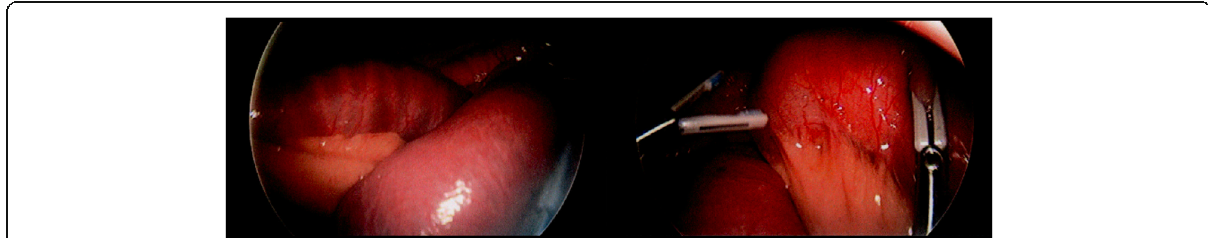
Fig. 2 Dilated loops of bowel. Intraoperatively, hyperemia and dilation of the proximal small bowel was noted from the distal duodenum to the mid-jejunum. Hypervascularity of the bowel wall is suggestive of vascular congestion secondary to increased luminal pressures exceeding venous pressures. There was no evidence of ischemia, necrosis, or